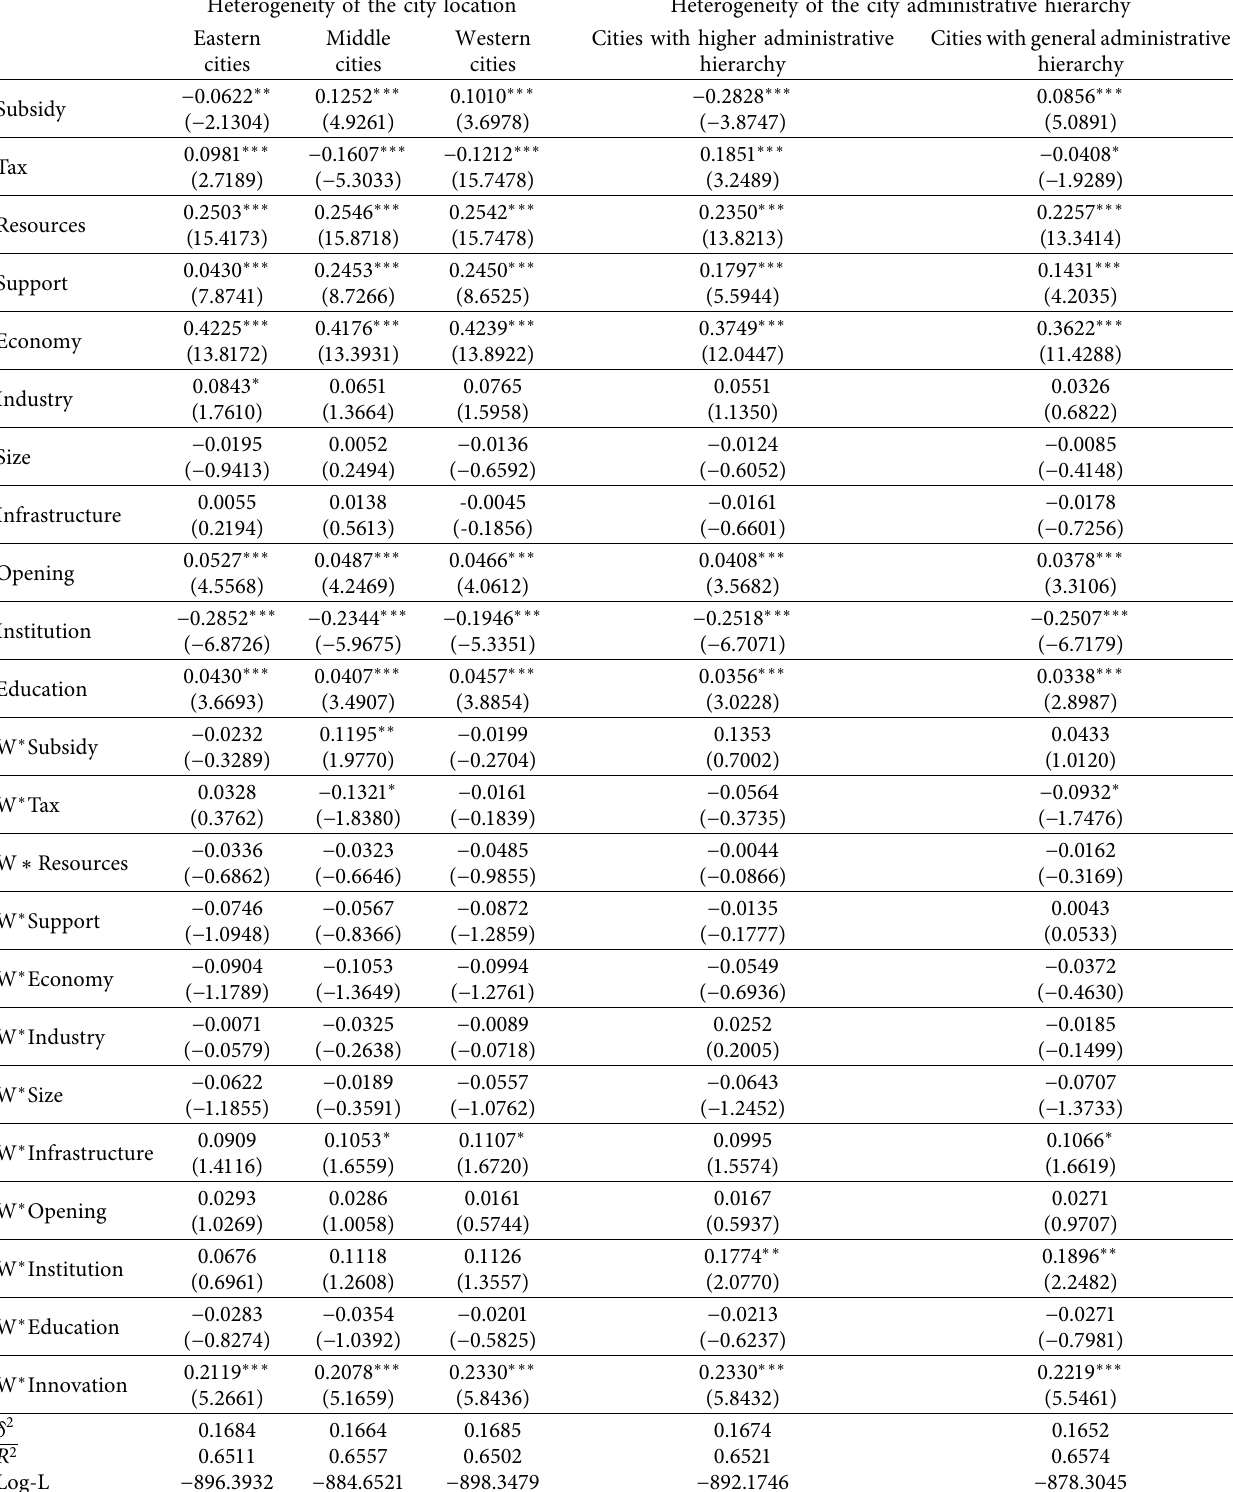
Table 10: Estimated results of heterogeneity